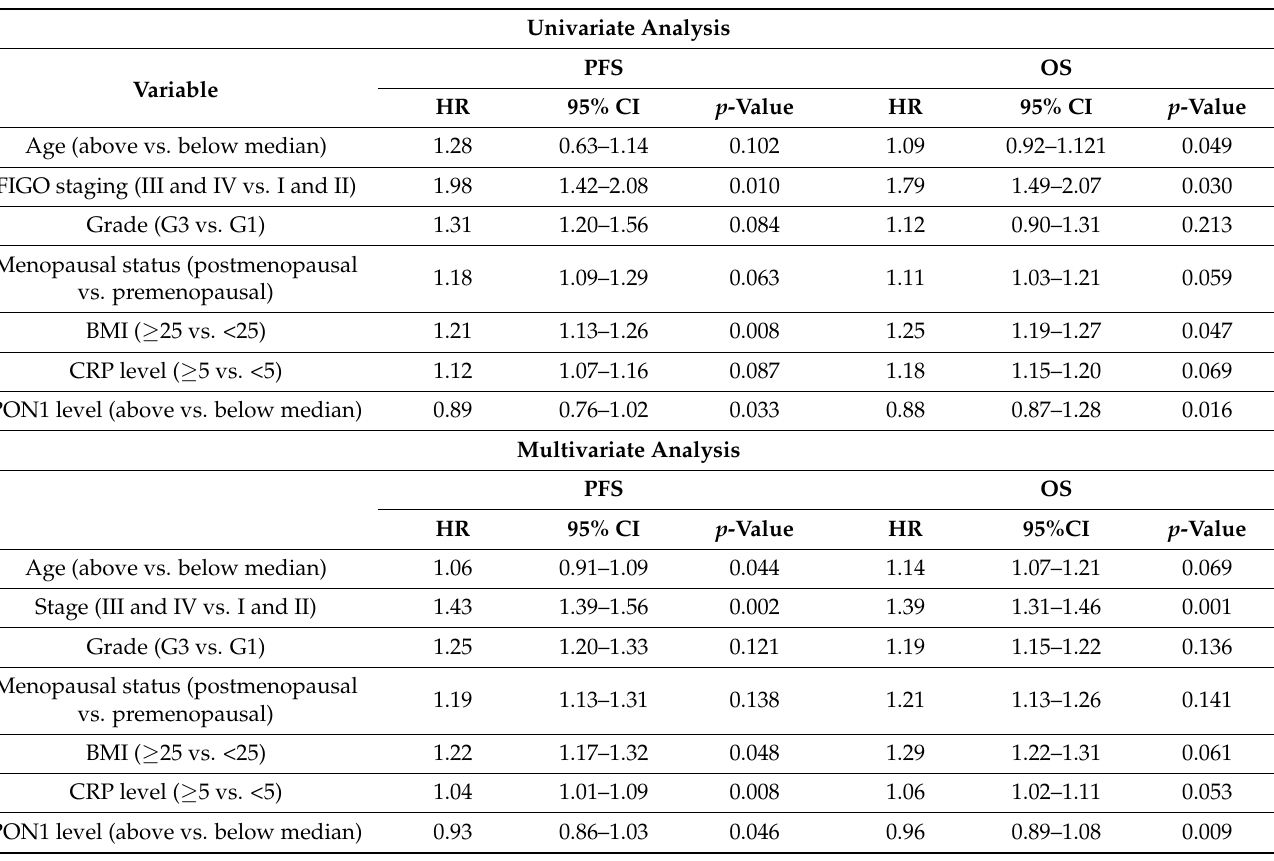
Table 7. Univariate and multivariate Cox regression model for PON1 serum concentrations.